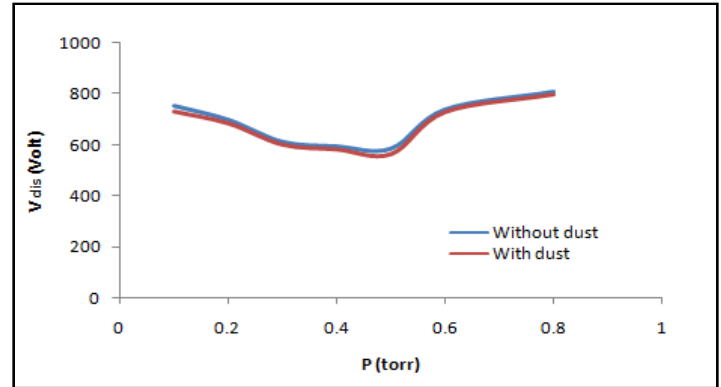
Fig.4: Schematic of the discharge voltage as a function of pressure at presence and absence of dust particles.